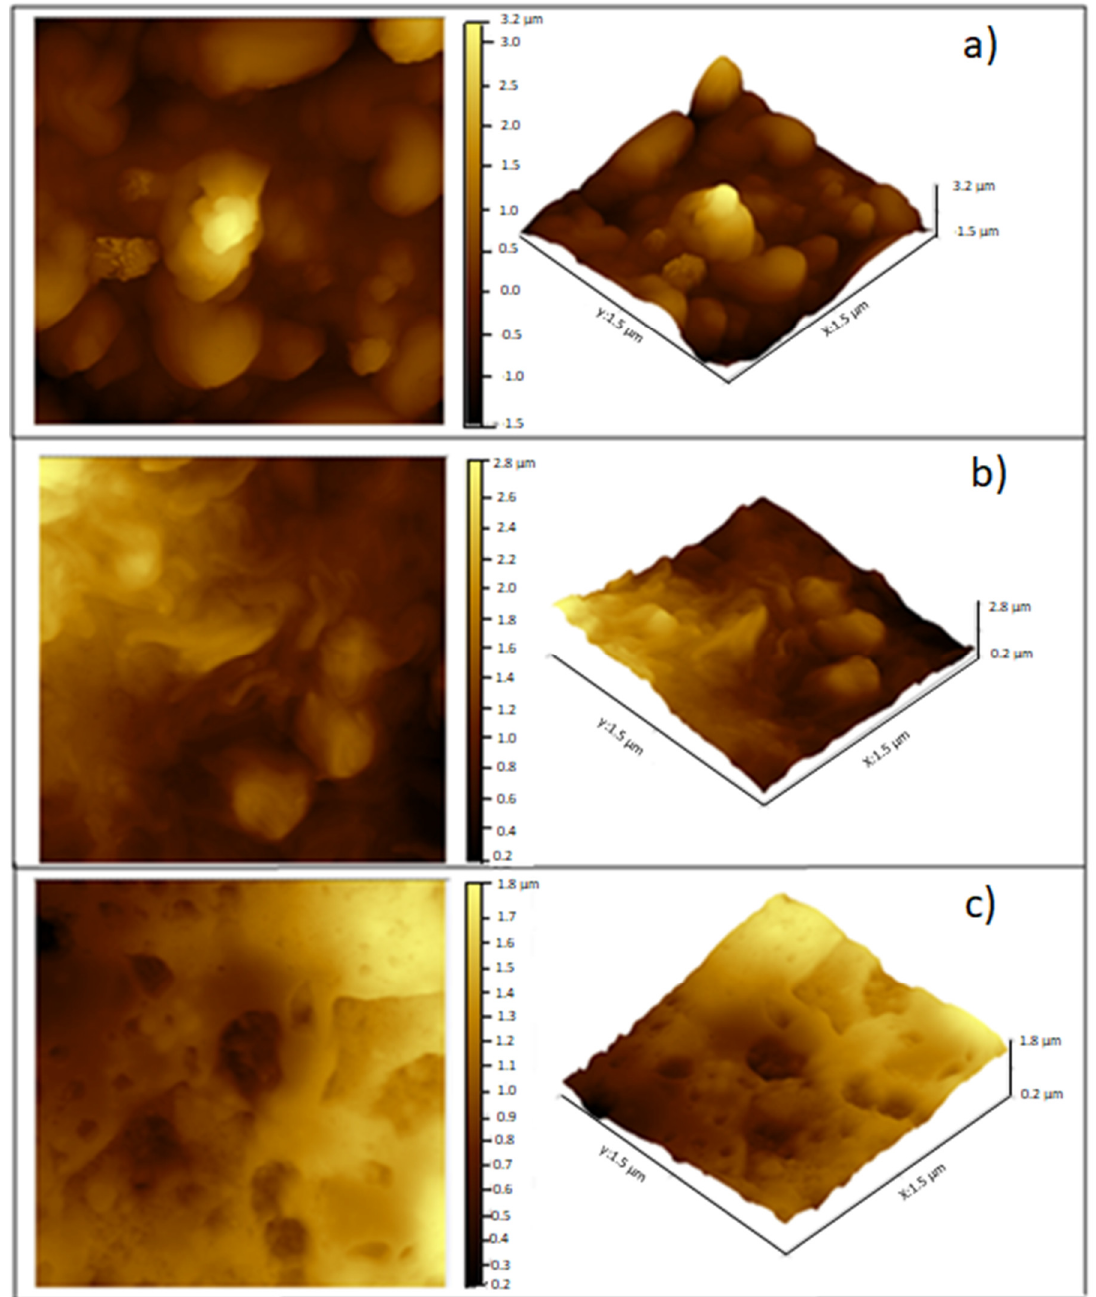
Figure 6. Visualization by AFM of the antimicrobial effect on Micrococcus luteus of EOs incorporated into the filmogenic suspension. ( a ) Control, ( b ) Rosemary essential oil, ( c ) Thyme essential oil.